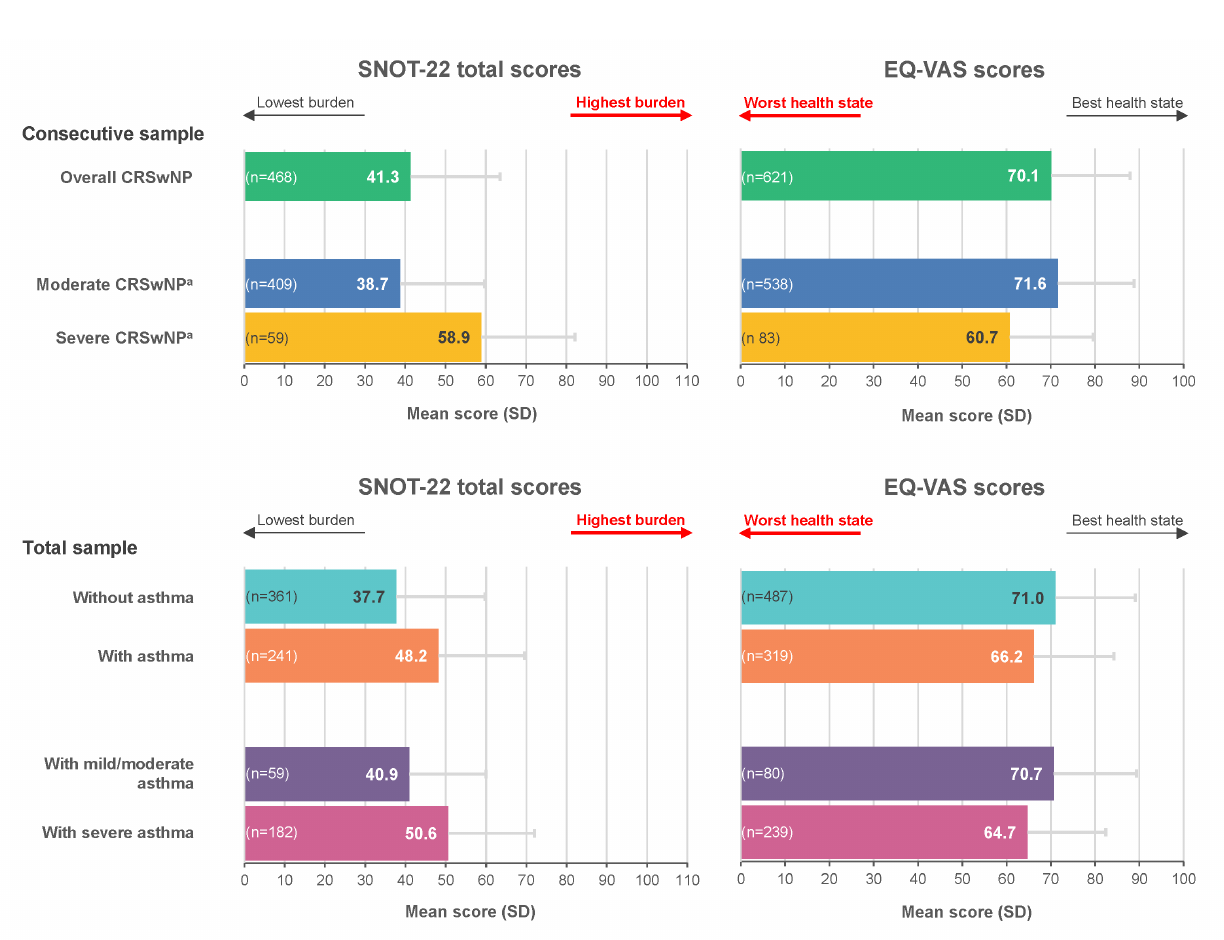
Figure 5. Patient-reported burden of CRSwNP symptoms on overall health-related quality of life. a CRSwNP severity determined by physician for each patient based on physician’s clinical expertise and provided guidance to follow the European Position Paper on Rhinosinusitis and Nasal Polyps guide- lines (2,10) and NP size scoring systems. Gray line indicates SD. Abbreviations: CRSwNP, chronic rhinosinusitis with nasal polyposis; EQ-VAS, EuroQoL visual analogue scale; NP, nasal polyp; SNOT-22, 22-item Sino-Nasal Outcome